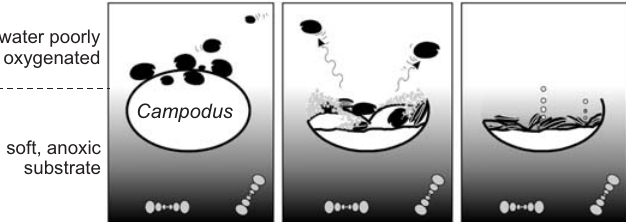
Fig. 2. Schematic taphonomic model for the shark-ostracod association il- lustrating the key stages in its development; after Wilby et al.